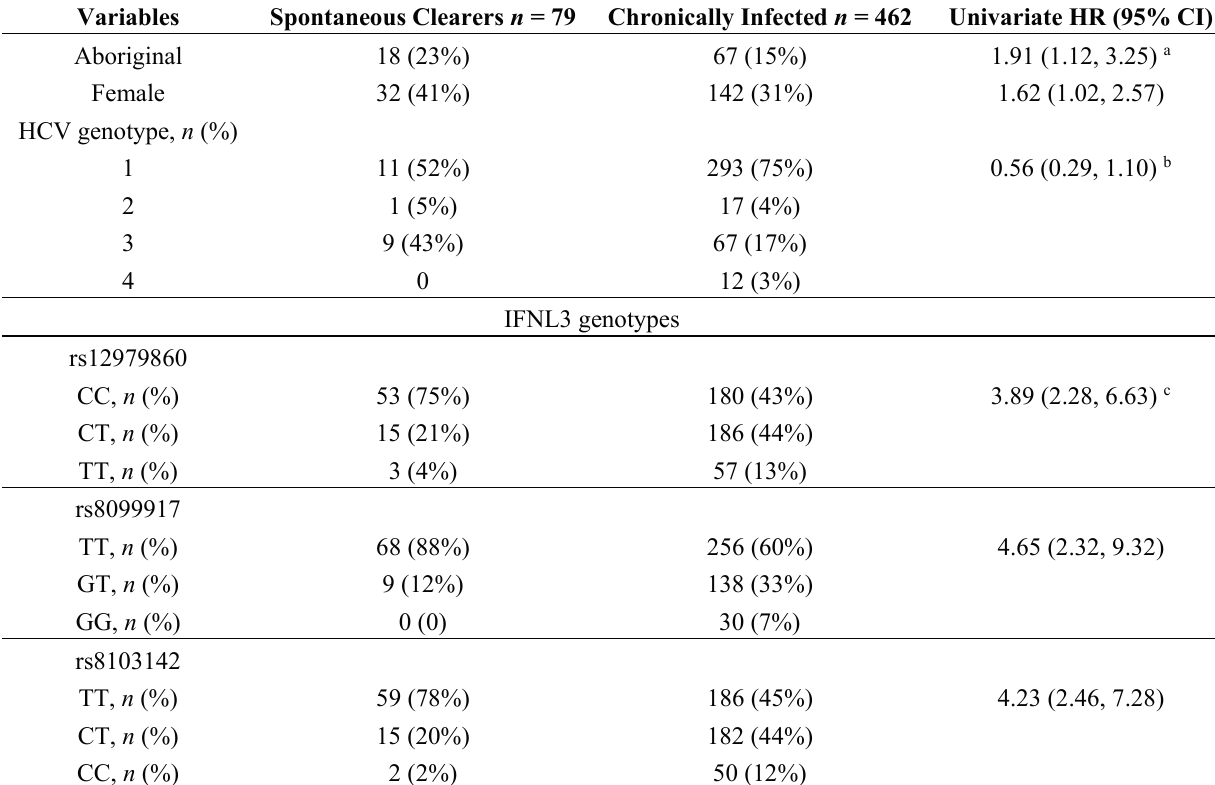
Table 2. Characteristics of spontaneous clearers compared to chronically HCV infected patients and univariate Cox proportional hazards analyses of spontaneous HCV